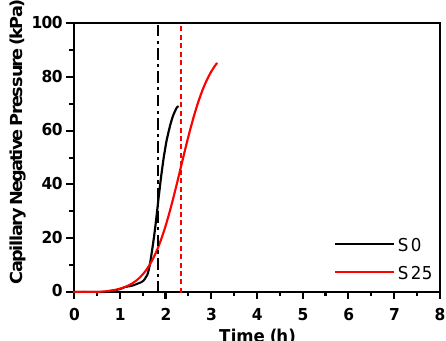
Figure 8. The development curve of capillary pressure inside concrete (the dotted line corresponds to the final setting time of concrete).